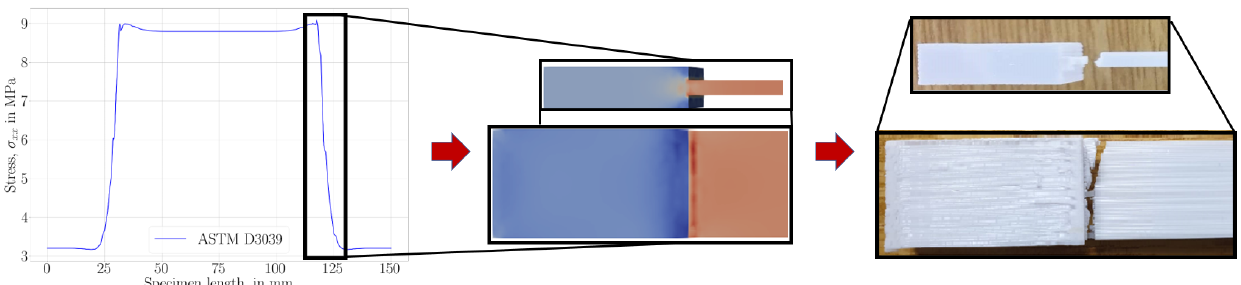
Figure 13. Schematic illustration of the stress concentration on ASTM D3039 specimens. Sharp stress increase is measured and visualized by finite element simulations ( left ). This outcome is validated with experimental investigations ( right